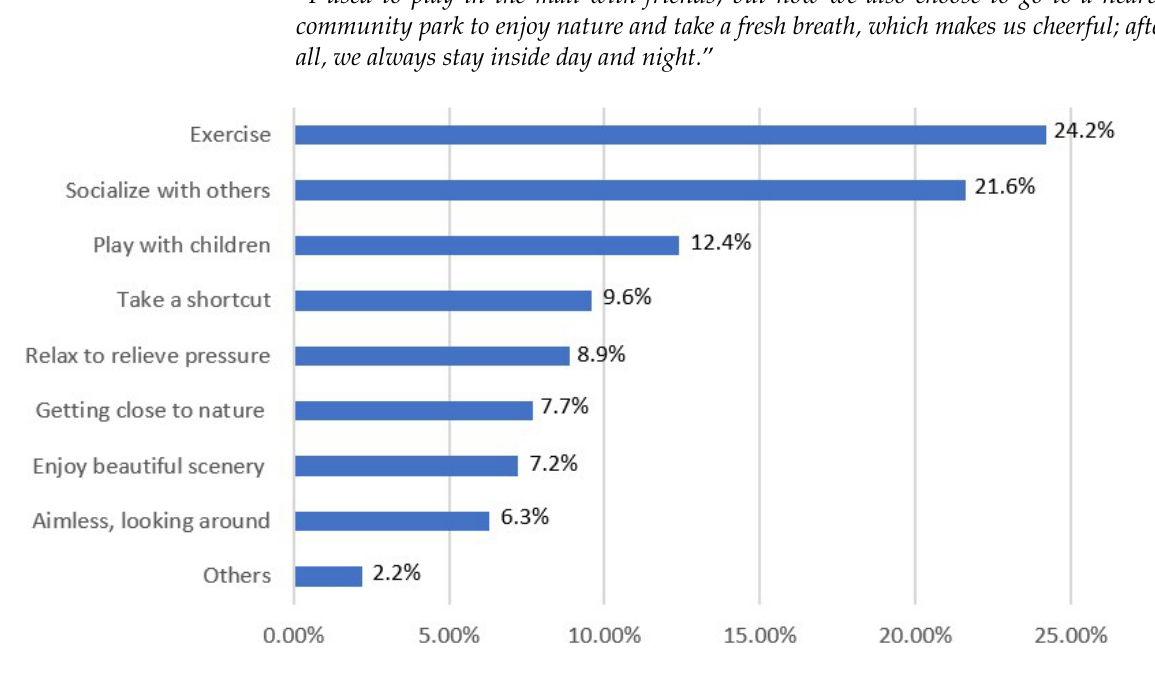
Figure 3. Motives for visiting community parks.